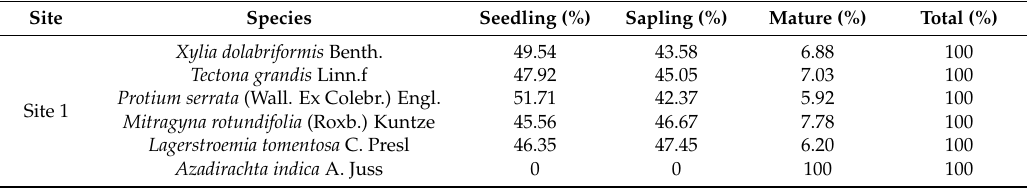
Table 6. Composition of seedlings, saplings, and mature trees of some species at six study sites.